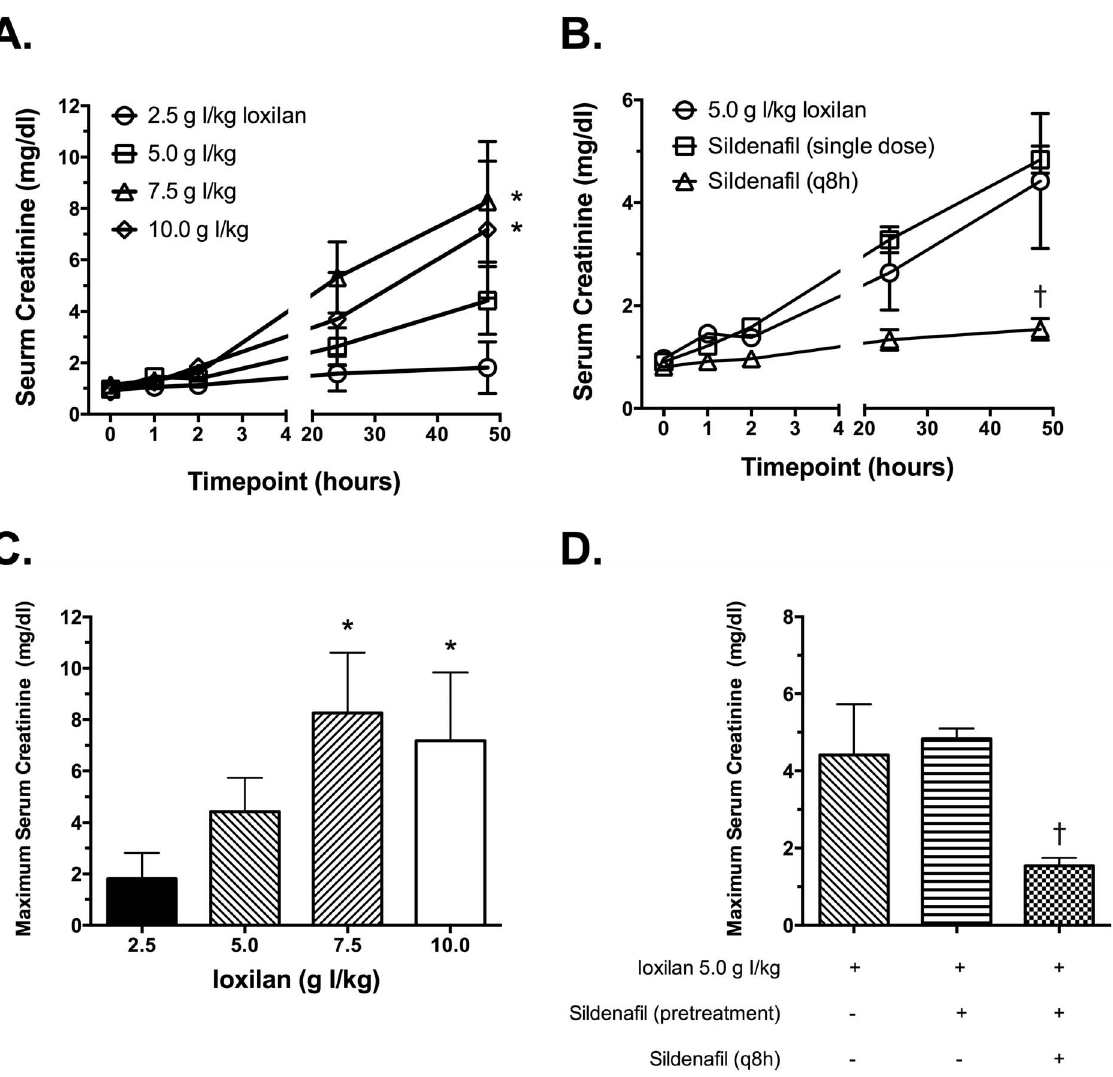
Figure 2. The effects of sildenafil citrate on CM-induced renal dysfunction. Serum samples were prepared from whole blood collected at various time points. Creatinine concentrations were determined using a Luminex xMap assay. (A) Time course of serum creatinine concentration in animals treated with increasing concentrations of CM. (B) Time course of serum creatinine concentration in animals pretreated with sildenafil citrate (6.0 mg/kg; single dose or q8 h) prior to CM exposure (5.0 g I/kg). (C) Maximum serum creatinine concentration in animals treated with increasing concentrations of CM. (D) Maximum serum creatinine concentration in animals pretreated with sildenafil citrate (6.0 mg/kg; single dose or q8 h) prior to CM exposure (5.0 g I/kg). Values are presented as mean ¡ SEM; n 5 3–5. * indicates p , 0.05 vs. 2.5 g I/kg and { indicates p , 0.05 versus 5.0 g I/kg by one-way ANOVA and Dunnett’s multiple comparisons